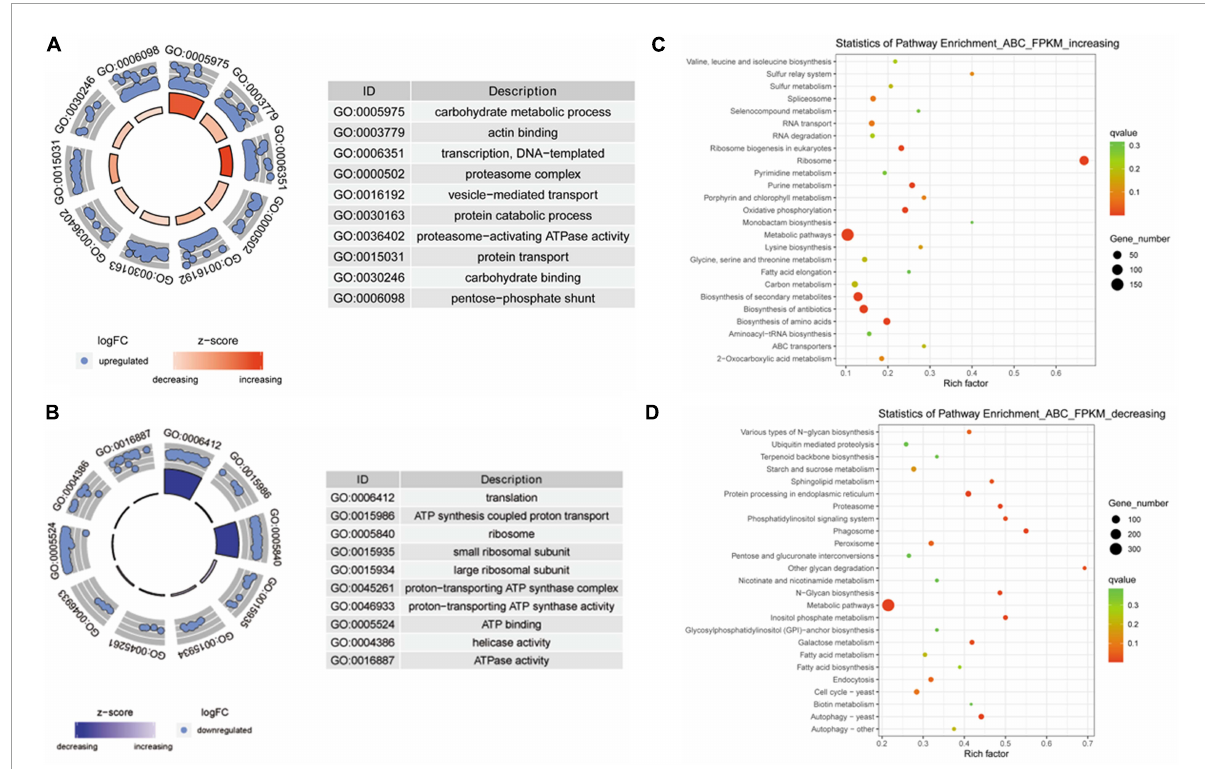
FIGURE3 Gene ontology (GO) and Kyoto Encyclopedia of Genes and Genomes (KEGG) analyses of differentially expressed genes in Fusarium oxysporum strains with different levels of virulence toward tobacco. (A) GO analysis for genes that were negatively associated with virulence. These genes are enriched in the terms including carbohydrate metabolism, protein catabolic process, and carbohydrate binding. (B) Genes that were positively correlated with virulence show enrichment for the terms including ATP synthesis coupled proton transport, ATP binding, and ATPase activity. (C) KEGG analysis of the genes with negative correlation with virulence shows enrichment in categories including RNA transport, ribosome, and ABC transporters. (D) The genes with expression levels that positively correlated with virulence are classified into categories including proteasome, metabolic pathways, and